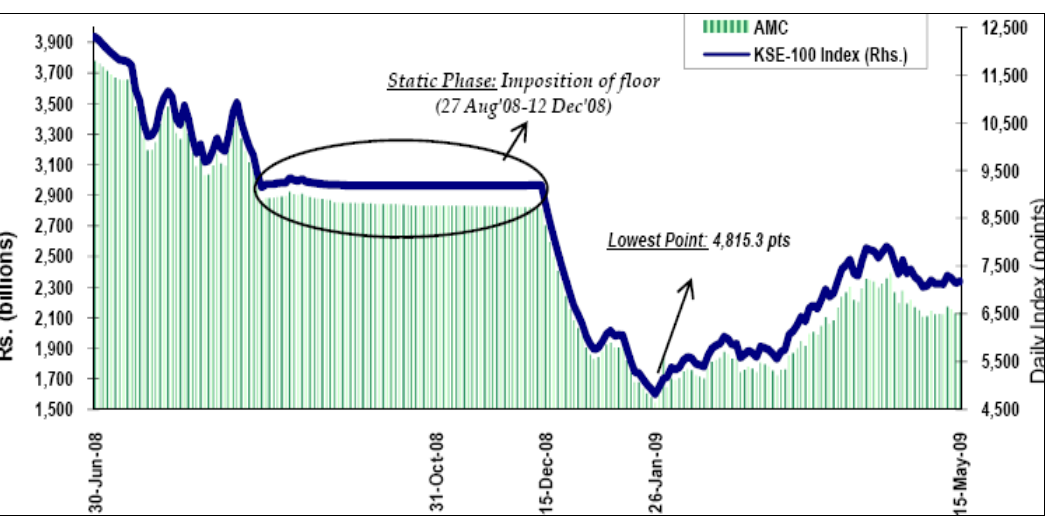
Source: Economic survey of Pakistan 2008-09, p.